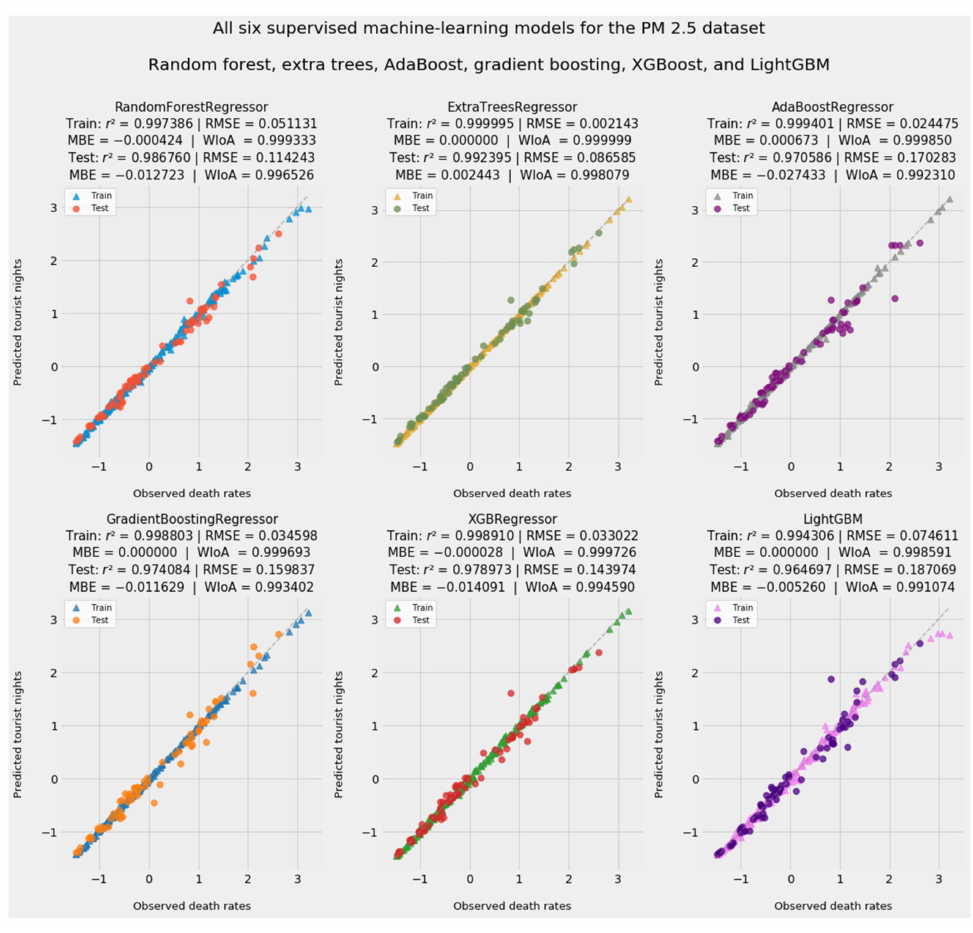
Figure 3. Fitted values and accuracy statistics for all supervised machine learning